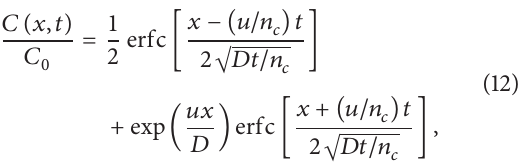
The junction potential term can be obtained by integrat- ing